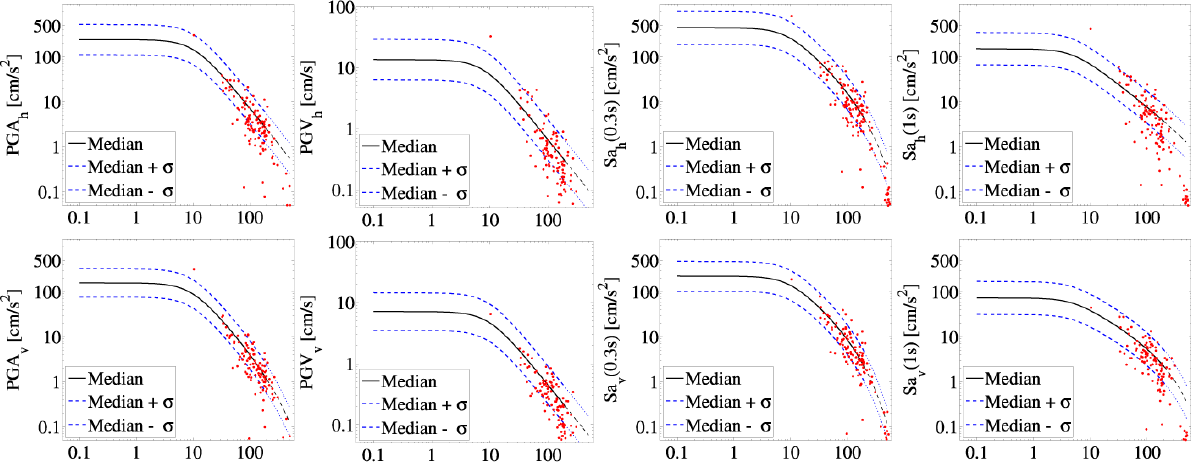
(0.3s), S (1.0s), for the geometric mean of the horizontal (h sub- a a (km). jb